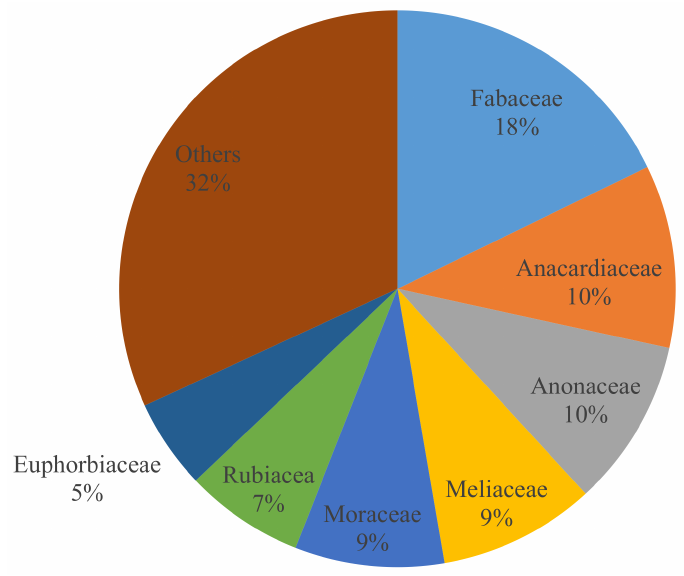
Figure 3. Proportion of tree stem based on different